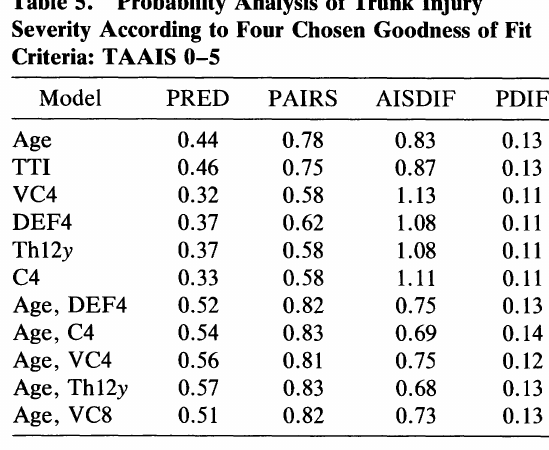
Table 5. Probability Analysis of Trunk